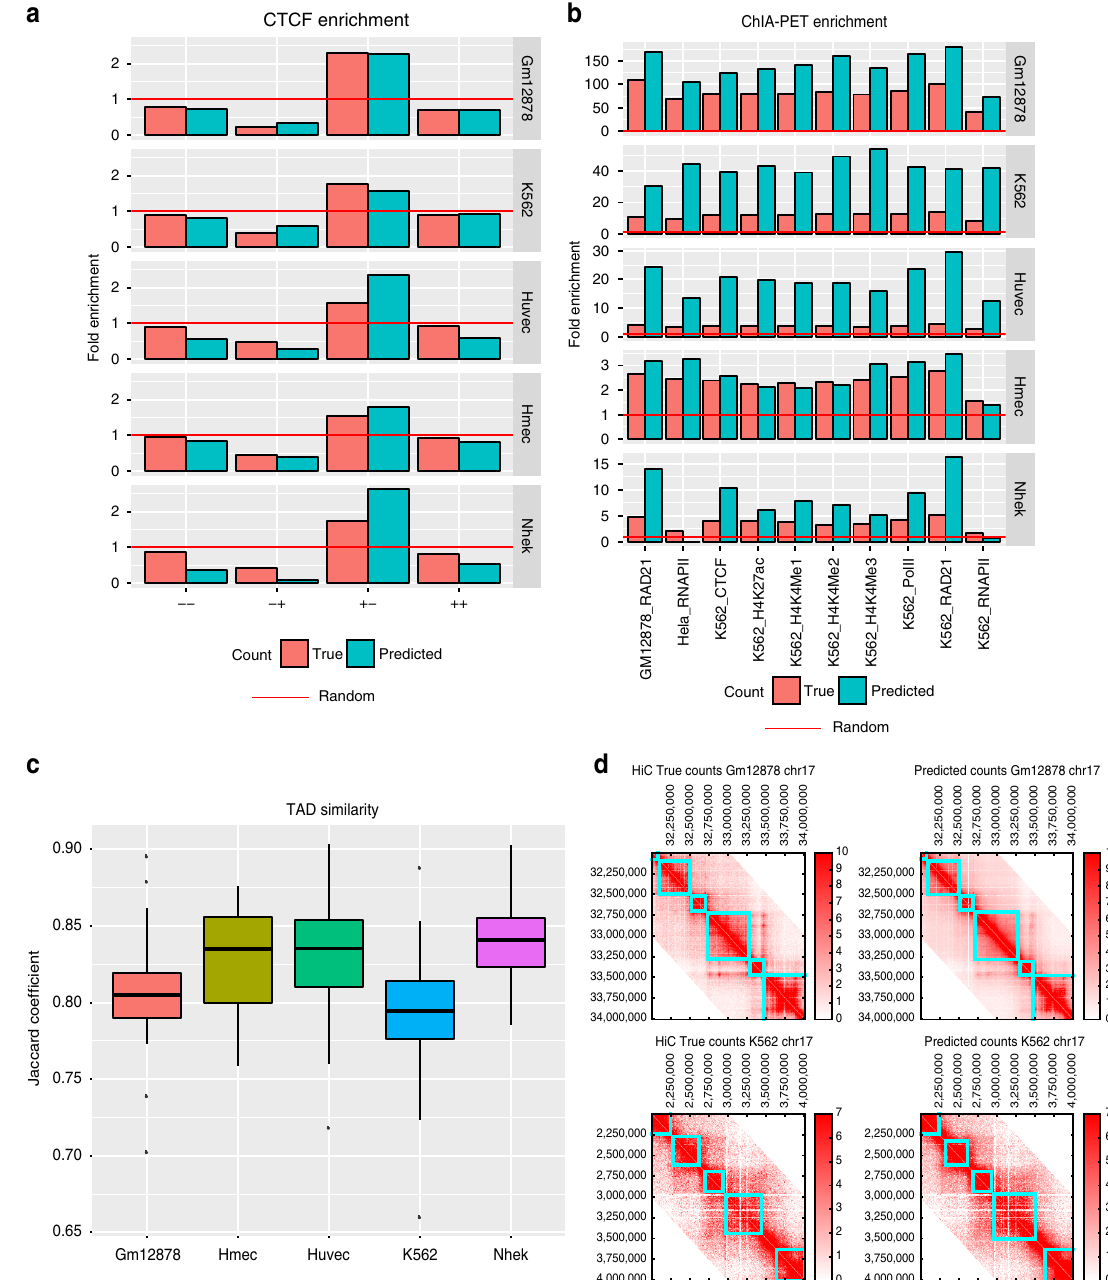
Fig. 5 Assessing signi fi cant interactions and TADs from HiC-Reg predictions. a Fold enrichment of four con fi gurations of CTCF motifs in signi fi cant interactions identi fi ed using true and predicted counts. A fold enrichment > 1 (red horizontal line) is considered as enriched. Fold enrichment in all fi ve cell lines is shown. b Fold enrichment of interactions identi fi ed using ChIA-PET experiments in signi fi cant interactions from HiC-Reg ’ s predictions and true counts. A fold enrichment > 1 (red horizontal line) is considered as enriched. c Distribution of TAD similarity identi fi ed from true and predicted counts for all chromosomes. Each point in the box plot corresponds to the average Jaccard coef fi cient for a chromosome. The horizontal middle line of each plot is the median. The bounds of the box are 0.25 quantile ( Q 1 ) and 0.75 quantile ( Q 3 ). The upper whisker is the minimum of the maximum value and Q 3 þ 1 : 5 (cid:3) IQR , where IQR ¼ Q 3 (cid:4) Q 1 . The lower whisker is the maximum of the minimum value and Q 1 (cid:4) 1 : 5 (cid:3) IQR . d TADs identi fi ed on true (left) and predicted (right) HiC count matrices for selected regions. Top: Gm12878 cell line, chr17:32 – 34 Mbp. Bottom: K562 cell line, chr17:2 – 4 Mbp). Source data are provided as a Source Data fi le. by taking the average of the predictions (Fig. 6, ENSEMBLE). We fi nd that the ensemble predictions are at least as good as the predictions from the individual models (Fig. 6a orange line) and the ensemble for the MULTI-CELL features is better than that for the WINDOW features (Fig. 6b). NATURE COMMUNICATIONS| (2019) 10:5449